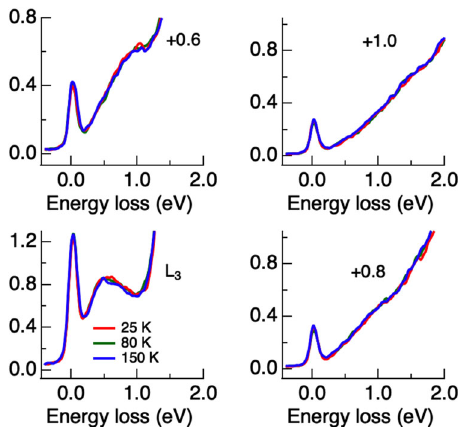
Fig. 2 | Excitonic excitation of optimally doped Bi2212. a , b RIXS spectra at selected incident photon energies for Q ∥ =( π , 0) and temperatures above and below T c =89K.Theincidentphotonenergyisdenotedasitsenergyrelativetothe L 3 absorption peak in units of eV. Spectra above and below T c are normalized for energy loss integrated between 1.7 and 13eV to highlight the difference caused by the change in temperature; the self-absorption effect of either the incident or the scattered photons was not corrected, because the change in temperature is not affectedbytheself-absorption.FromtheestimateshowninsupplementaryFig.S3, L 3 corresponds approximately to E F . c Calculated RIXS resulting from excitonic excitation in the superconducting (SC) (red curves) and pseudogap (PG) phases